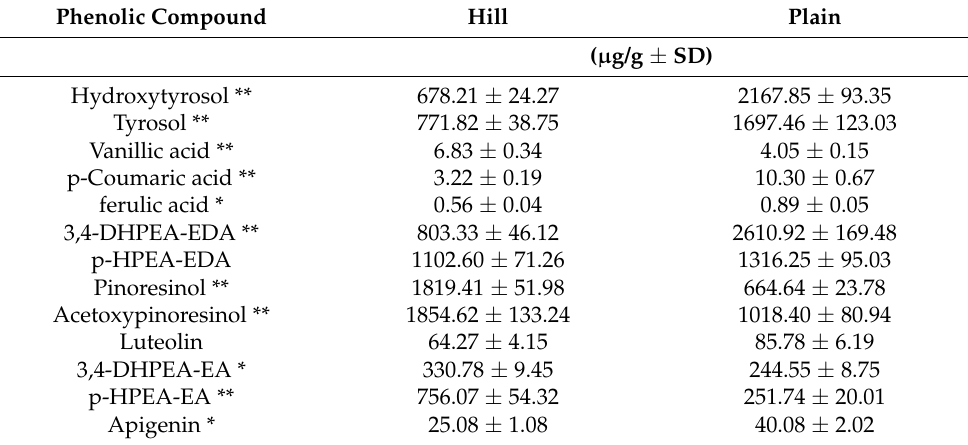
Table 3. Concentration of the main polar phenolic components in hill and plain EVOO’s